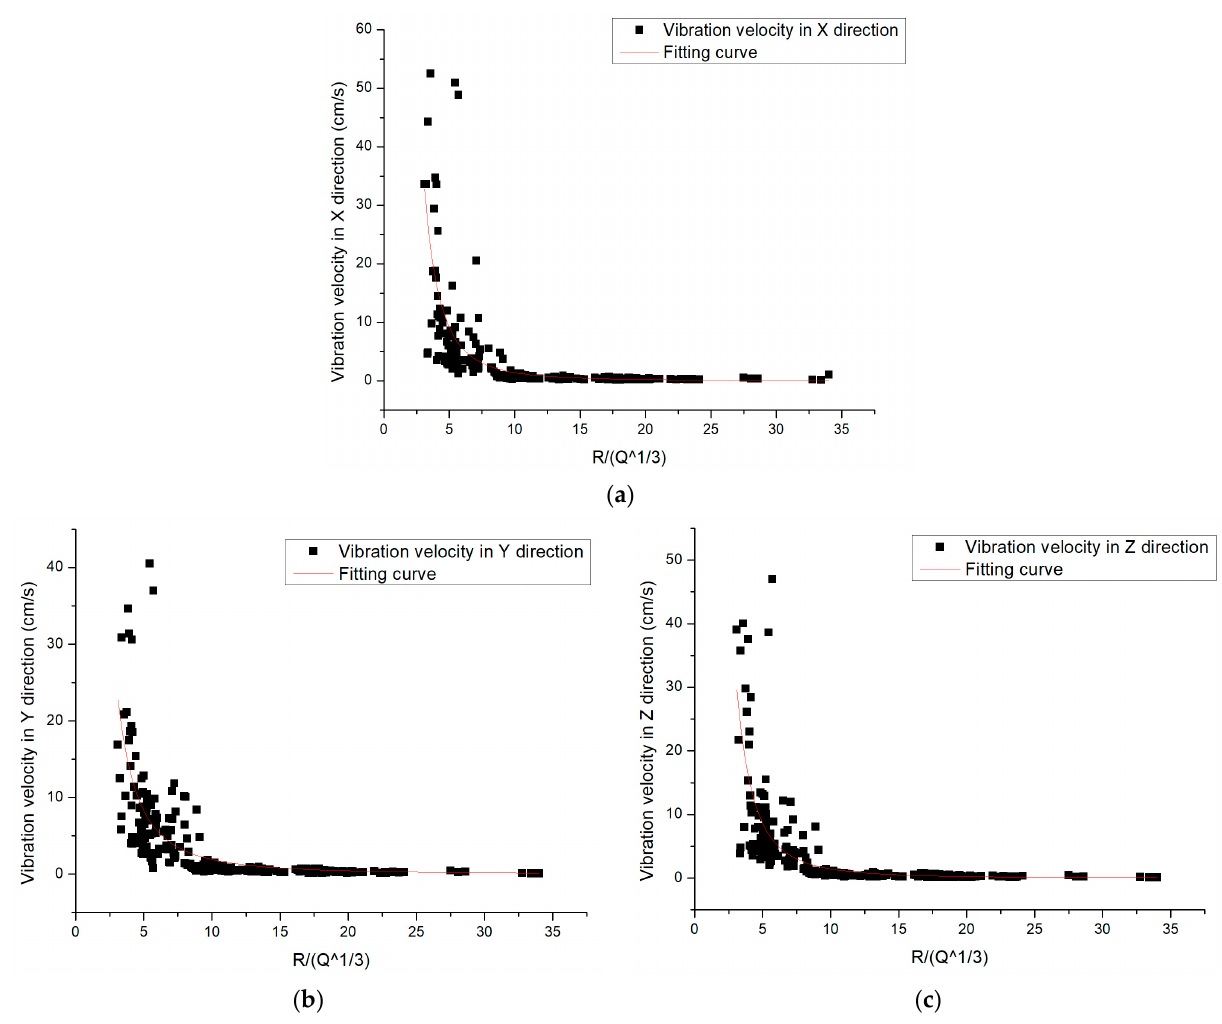
Figure 5. Vibration velocity in three directions of other blast holes in front of the working face: ( a ) X direction; ( b ) Y direction; ( c ) Z direction.